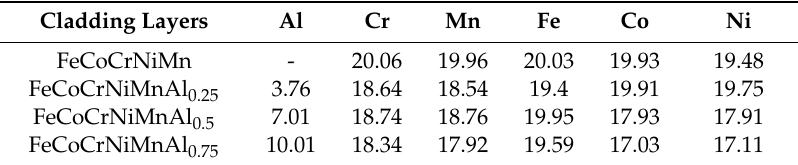
Table 3. EDS results of the FeCoCrNiMnAl x cladding layers (at.%).